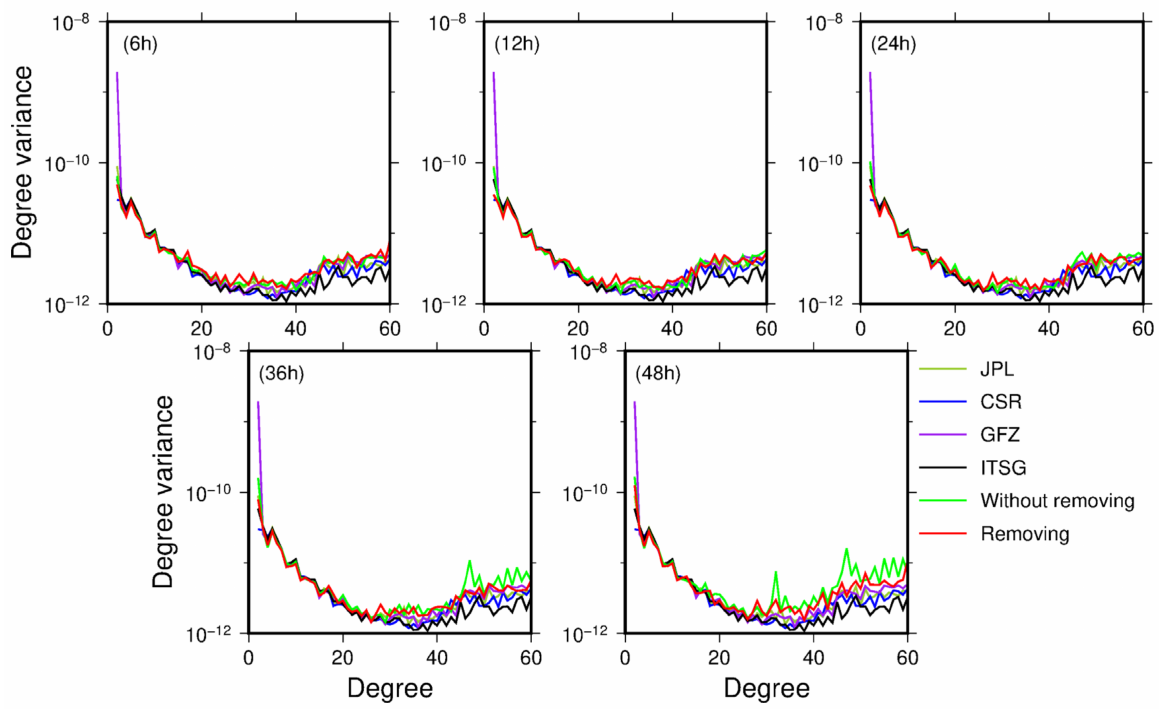
Figure 8. The degree variance of the recovered time-variable gravity field model based on the GRACE data of Jan.